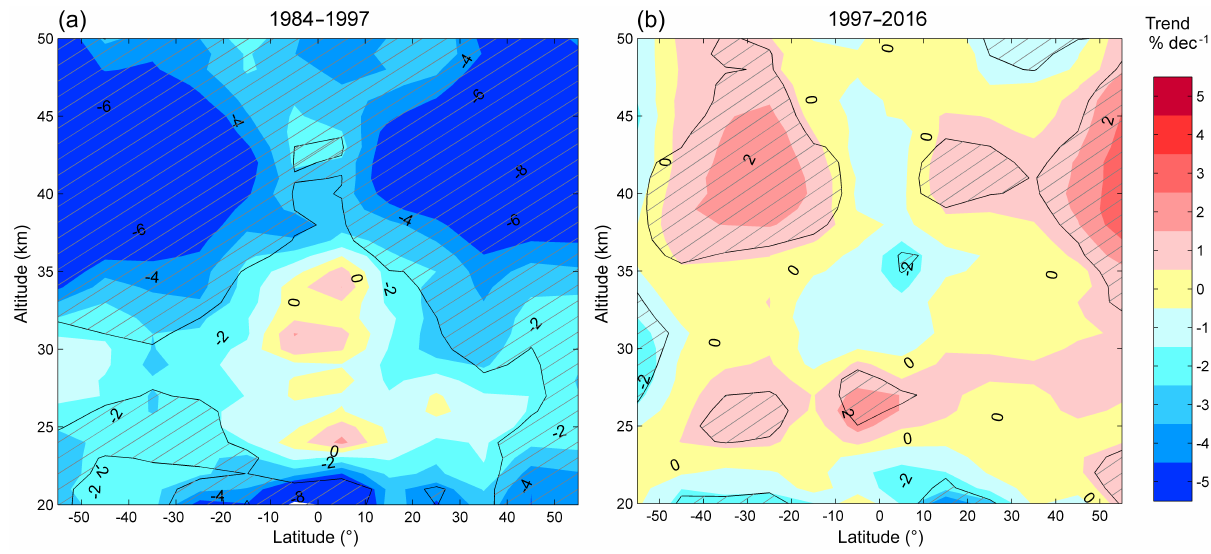
Figure 10. The ozone trend (% decade − 1 ) for different latitudes for 1984–1997 (a) and 1997–2016 (b) . Shaded areas show regions where trends are statistically different from zero at the 95% level.